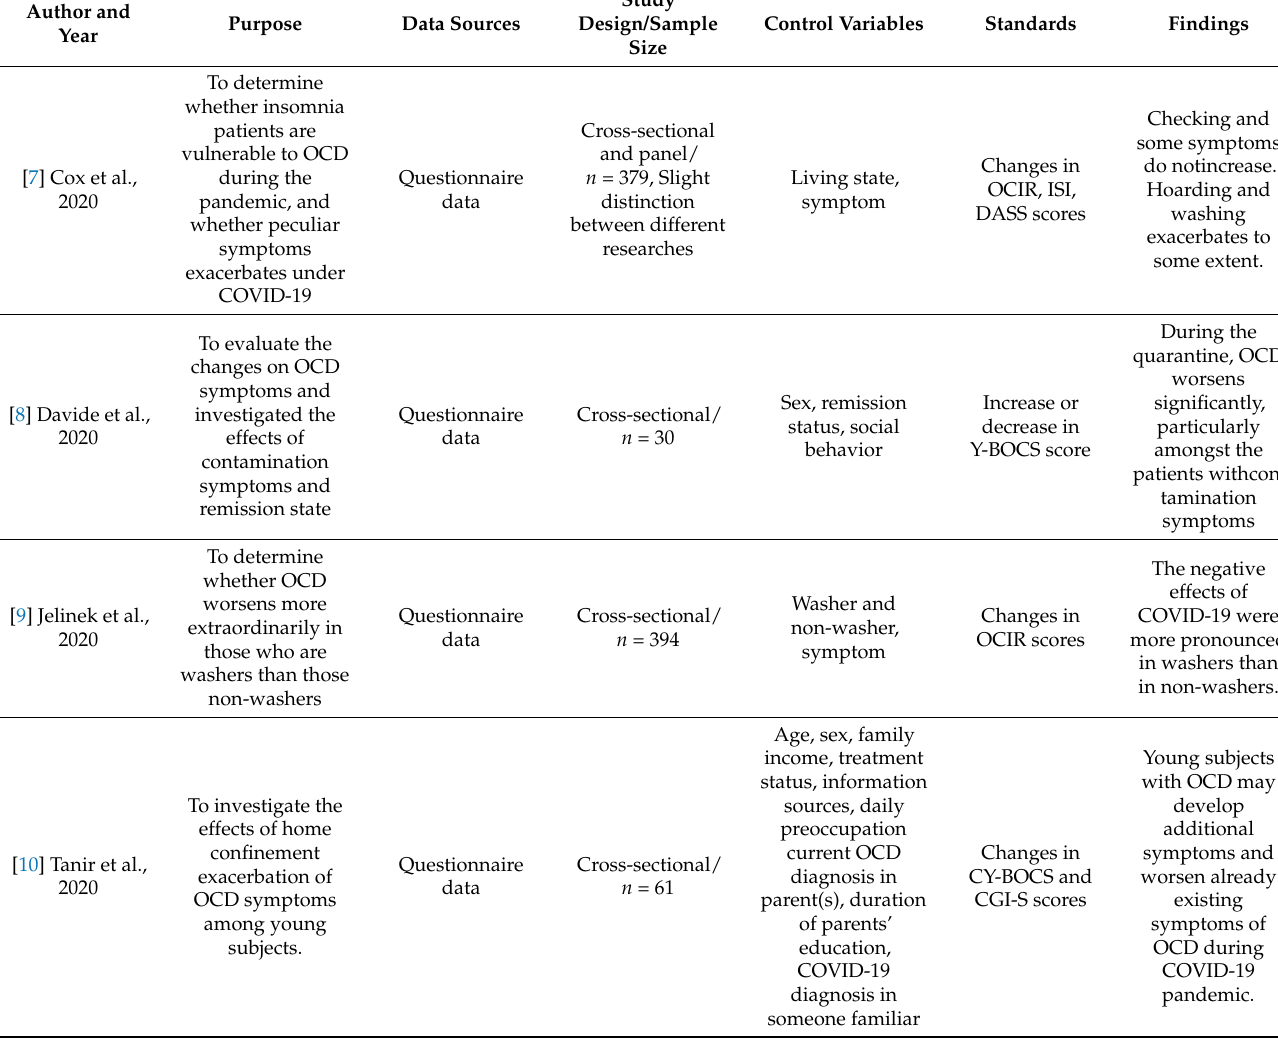
Table 1. Data extraction of included